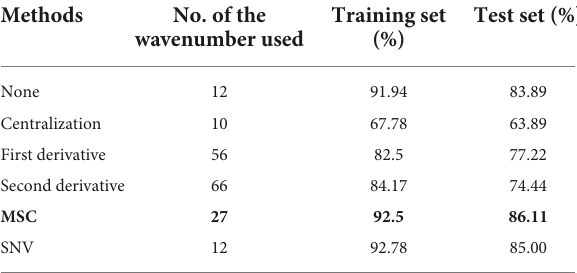
TABLE 3 Identification rates of the Fisher LDA models to classify the adulterated duck blood tofu with different spectra preprocess methods and wavenumbers selected.